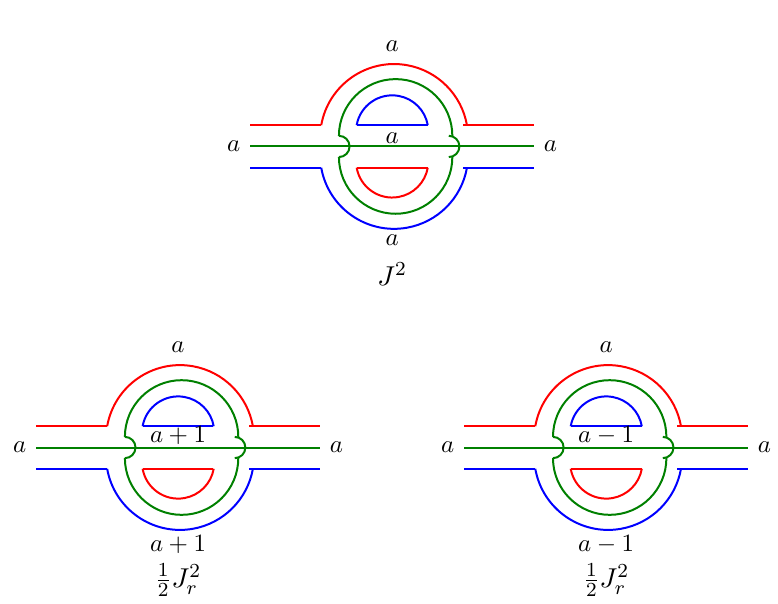
Figure 10. Contribution of interactions to melonic diagram. One can easily generate contributions from vertices of other colors by permuting lattice indices in the internal strand of melonic diagram.